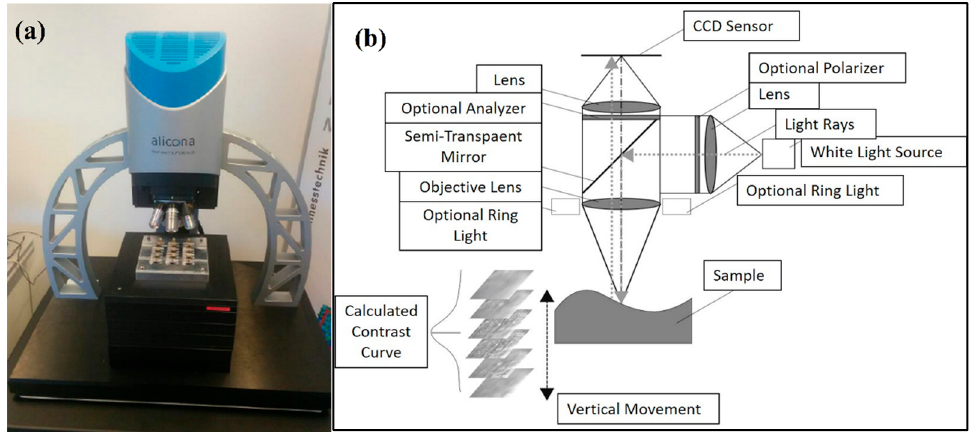
Figure 16. ( a ) Alicona microscopic assessment of implants and ( b ) principle of focus variation.